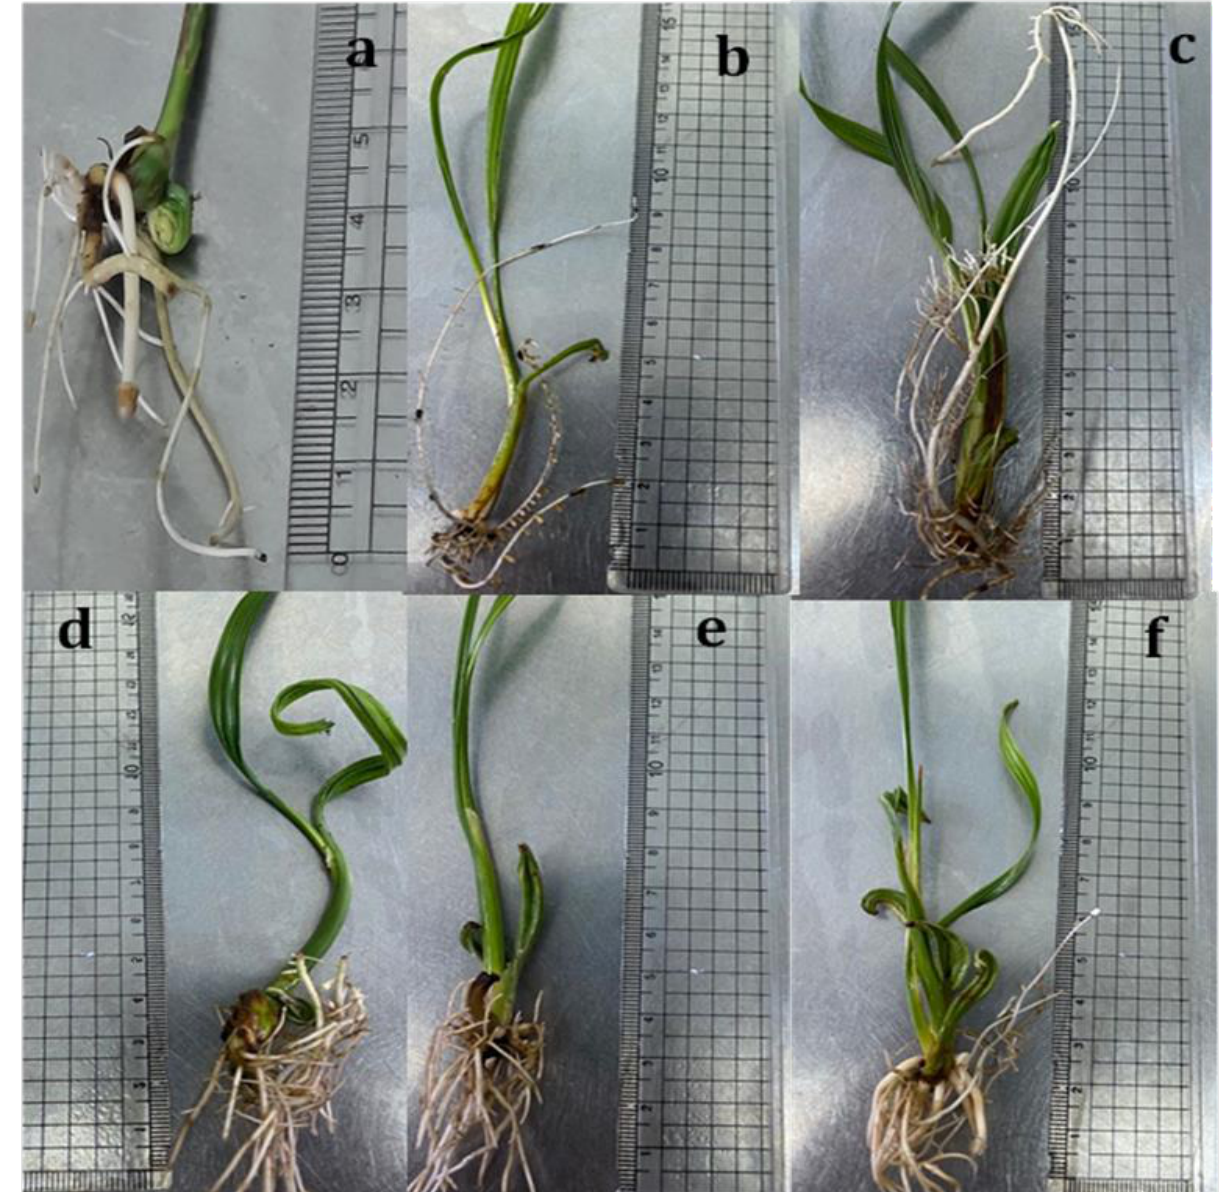
Figure 7. The influence of AC, Fe-AC , ZnO-NPs, and ZnO-BPs on root growth and development of date palm cv. Medjool; the treatments were supplemented as follows: ( a ) no ZnO and 0.1 g/L AC; ( b ) no ZnO and 0.1 g/L Fe-AC (note the poor development of the root system in both a and b figures